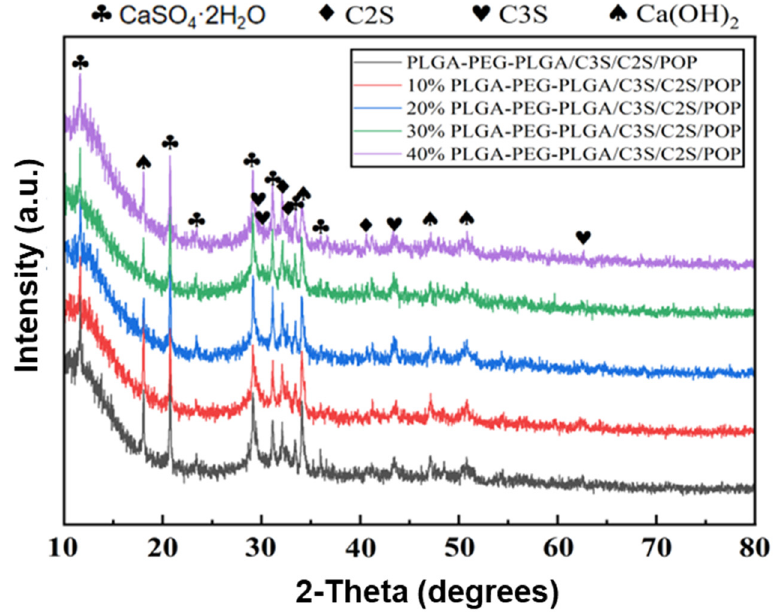
Figure 3. XRD pattern of hydration products of PLGA-PEG-PLGA/C3S/C2S/POP bone cement. The standard card numbers (ICDD PDF NO) corresponding to the objects shown in the figure are as follows: CaSO 4 2H 2 O: 33–0311, C 3 S: 49–0442, C 2 S: 33–0302, Ca(OH) 2 : 44–1481.